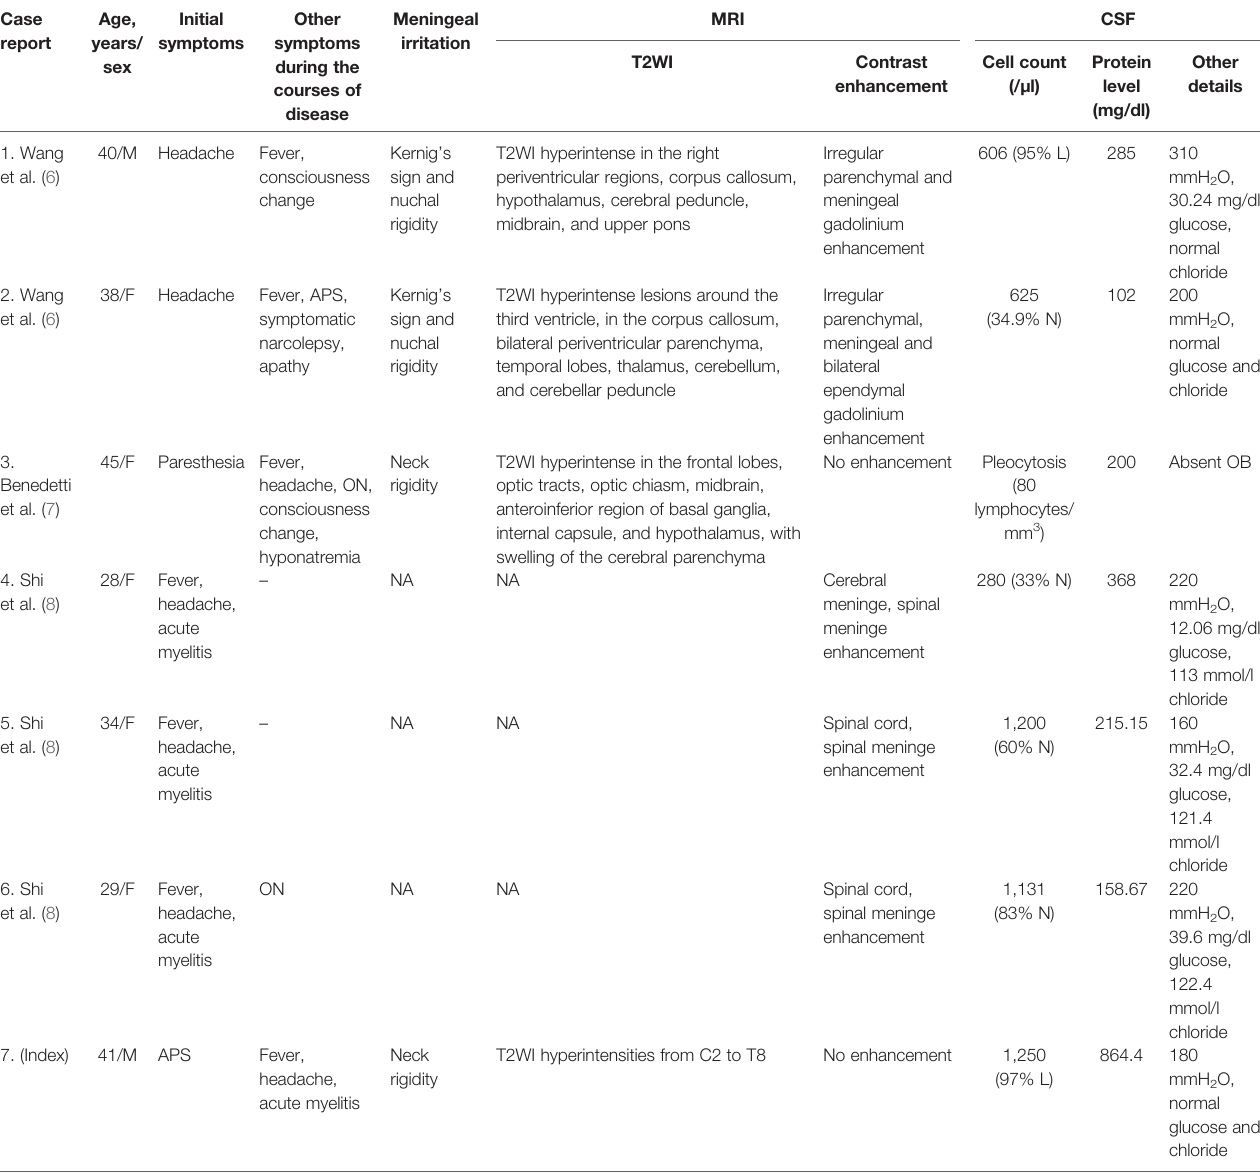
TABLE 1 | Clinical, MRI, and CSF characteristics of AQP4 antibody-seropositive NMOSD patients with meningitis/meningomyelitis-like symptoms at fi rst attack. Case